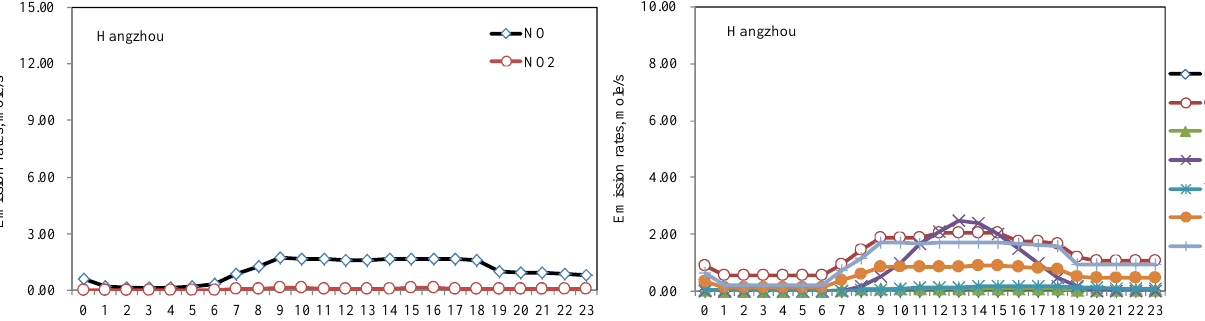
Fig. 15. Emission inputs of NO x and main VOC species at the Hangzhou site.